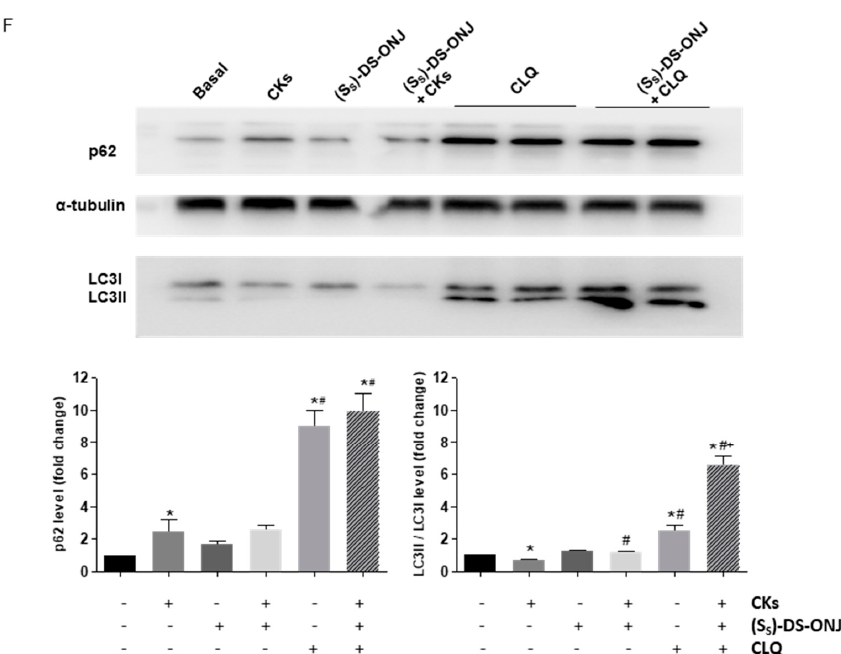
Figure 2. Resolution of inflammation in CKs-stimulated MCT cells by induction of autophagy flux in the presence of (S S )-DS-ONJ. ( A ) Protein extracts were analyzed by Western blot with the corresponding antibodies against iNOS and α -tubulin as a loading control. (n = 6 independent experiments). mRNA levels of Nos2 were determined by qRT-PCR. The results are expressed as means ± SEM. (n = 6 independent experiments performed in triplicate). ( B ) mRNA levels of Tnfa and Il1b were determined by qRT-PCR. (n = 3 independent experiments performed in triplicate). ( C ) Protein extracts were analyzed by Western blot with antibodies against caspase-1 and α -tubulin as a loading control. (n = 6 independent experiments). ( D ) Nlrp3 mRNA levels. Actinb as a housekeeping control was determined by qRT-PCR (n = 3 independent experiments performed in triplicate). ( E,F ) Protein extracts were analyzed by Western blot with antibodies against LC3II/I, p62 and α -tubulin as loading control for p62. (n = 4 independent experiments). The fold change relative to the basal condition is shown; * p ≤ 0.05 vs. Basal condition; # p ≤ 0.05 vs. CKs stimuli; + p ≤ 0.05 vs. CLQ stimuli (two-way ANOVA followed by Bonferroni t